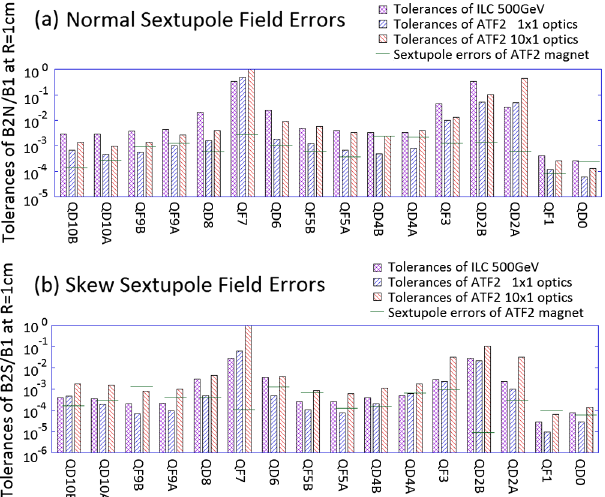
FIG. 4. Tolerances of sextupole field errors for all quadrupole magnets in the ILC and ATF2 final focus beam lines. The tolerances are defined as the error of each magnet required to induce a 2% IP vertical beam size growth. The measured multipole field errors of the ATF2 magnets are also